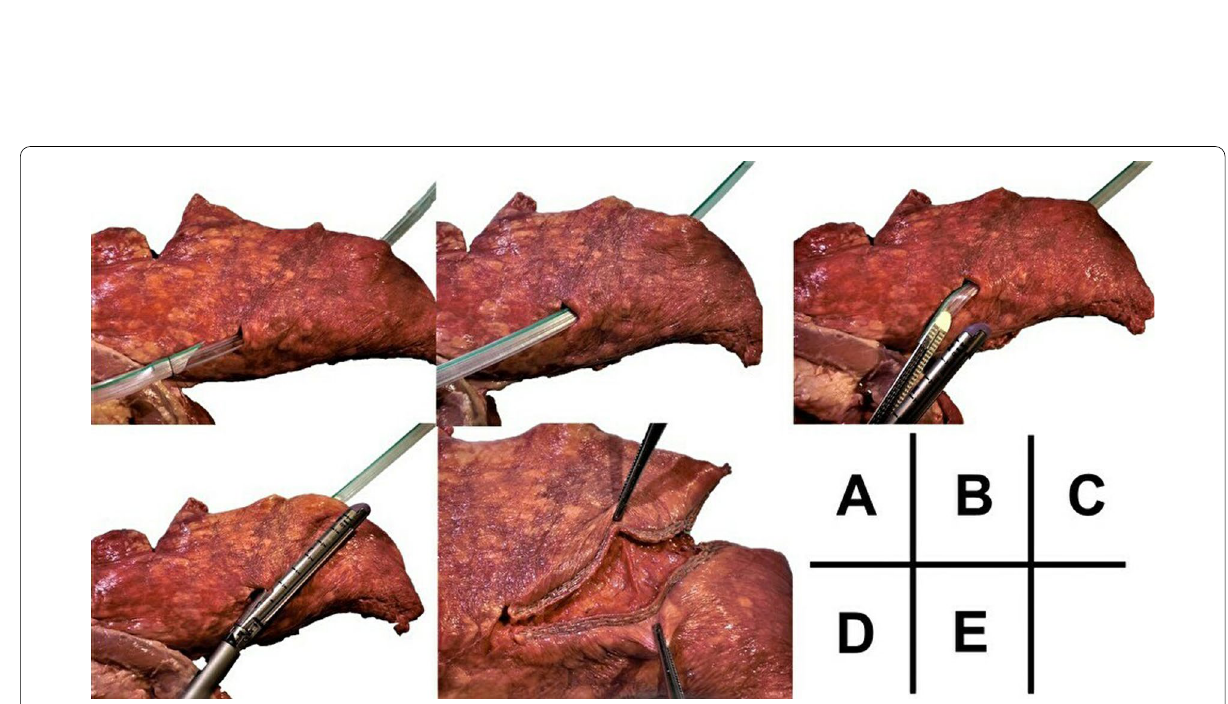
Fig. 3 Procedure (pig lung models): A the Penrose drain is fixed to the chest tube, which is removed; B the Penrose drain is seen fully penetrating the lung. C The Penrose drain was attached to the stapler, D which was guided into the wound tract. E Stapling made the wound tract